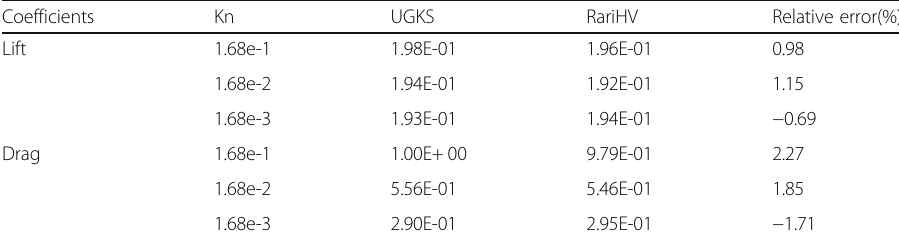
Table 5 Comparisons of X38-like coefficients with Mach number 8